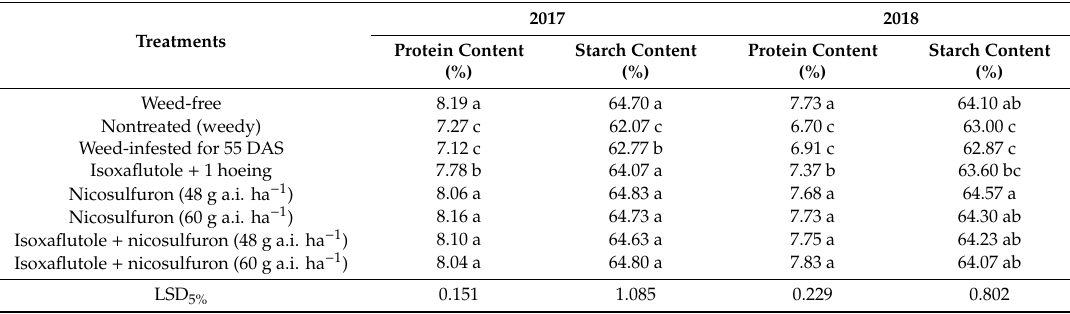
Table 2. Maize protein and starch content as a ff ected by the various treatments at the harvest stage, in 2017 and 2018 (Velestino, Greece). Means followed by di ff erent letters indicate significant di ff erences according to Fisher’s Least Significant Di ff erence (LSD) test ( p <